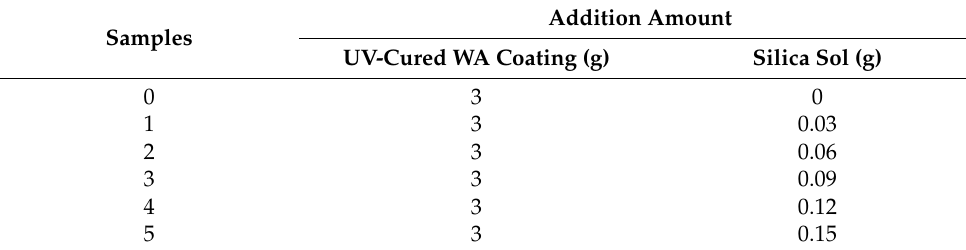
Table 1. The experimental materials and dosage.